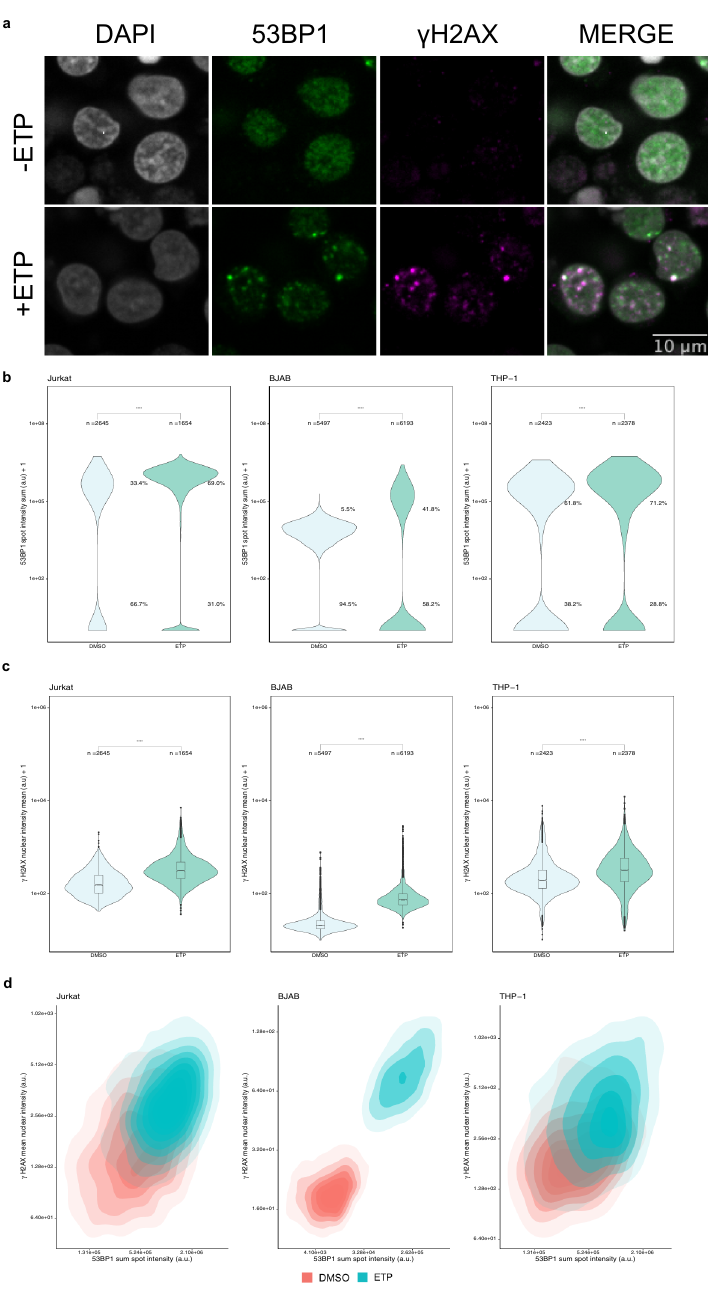
Figure 2. Detection of DNA damage in immune cell lines using HTI. ( a ) Jurkat cells were either treated with DMSO or treated with 30 µM etoposide (ETP) for 1.5 h before being subjected to HTI. DNA damage sites are indicated by an increase in signal intensity and foci formation of 53BP1 and γ-H2AX detected by specific antibodies. Scale bar: 8 µm. ( b ) Distribution of 53BP1 sum spot intensity in DMSO- or ETP-treated cells. Values indicate percentages of cells in the indicated populations. ****: p < 0.0001. ( c ) Distribution of γ-H2AX mean nuclear intensity in DMSO or ETP-treated immune cells. ****: p < 0.0001 using Mann–Whitney-Wilcoxon test. Number of analyzed cells (n) indicated for each sample. The values are representative of at least 3 independent experiments. Boxes represent the first and third quartiles of the distribution, the line represents the median and the whiskers represent the highest and lowest data points within 1.5 times the interquartile range (IQR) above the upper quartile and below the lower quartile. ( d ) Two-dimensional kernel density contour plots of the correlation between 53BP1 sum spot intensity and γ-H2AX mean nuclear intensity for both ETP-treated (blue) and untreated (red) immune cell lines for the dataset shown in panels B and C. N = 3 wells per sample with at least 197 cells per